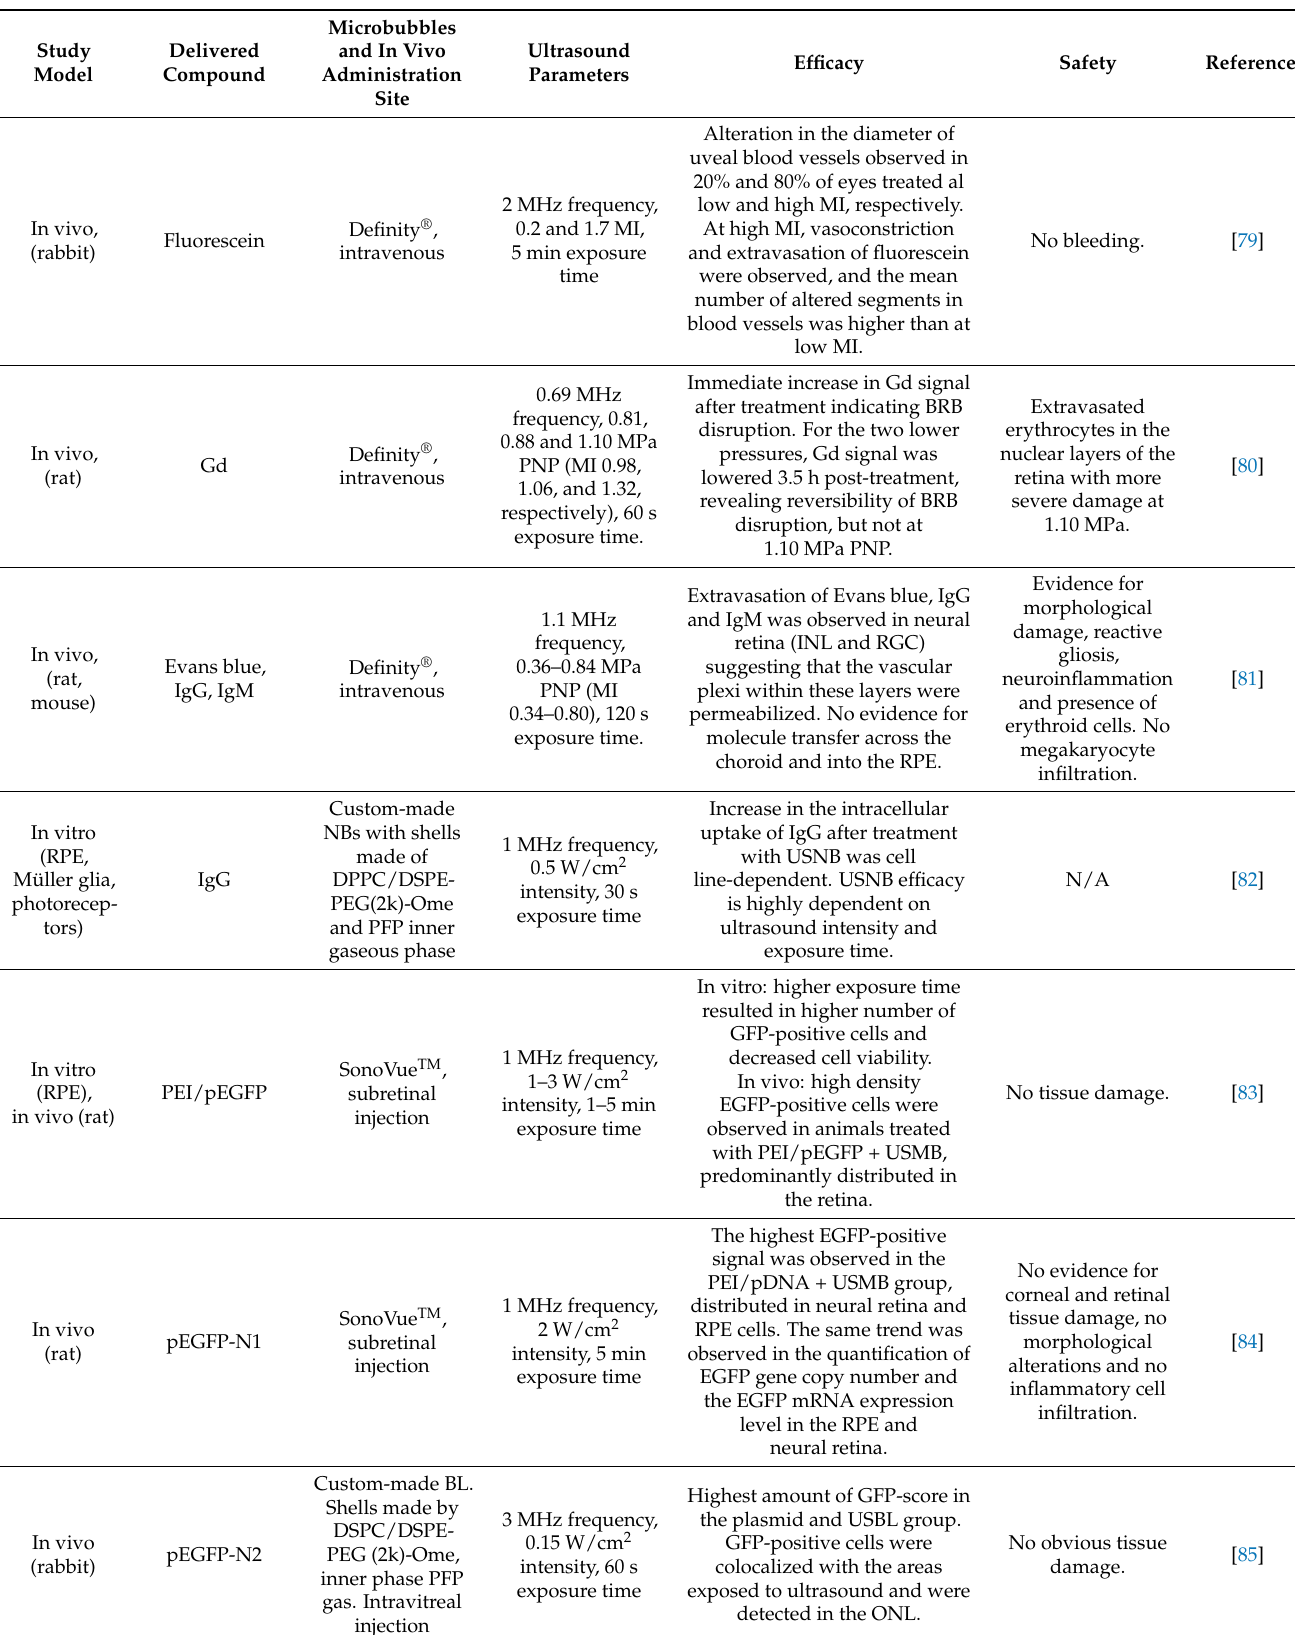
Table 1. Summary of the studies investigating the use of USMB in the treatment of ocular diseases. Study